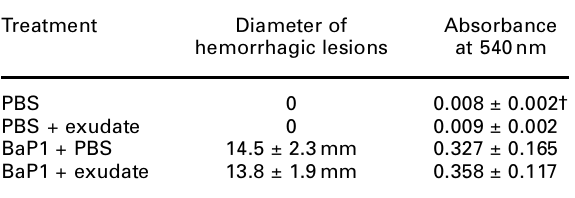
Table 2. Effect of the inflammatory exudate, obtained from mice injected with MT-III, on the hemorrhagic activity of metalloproteinase